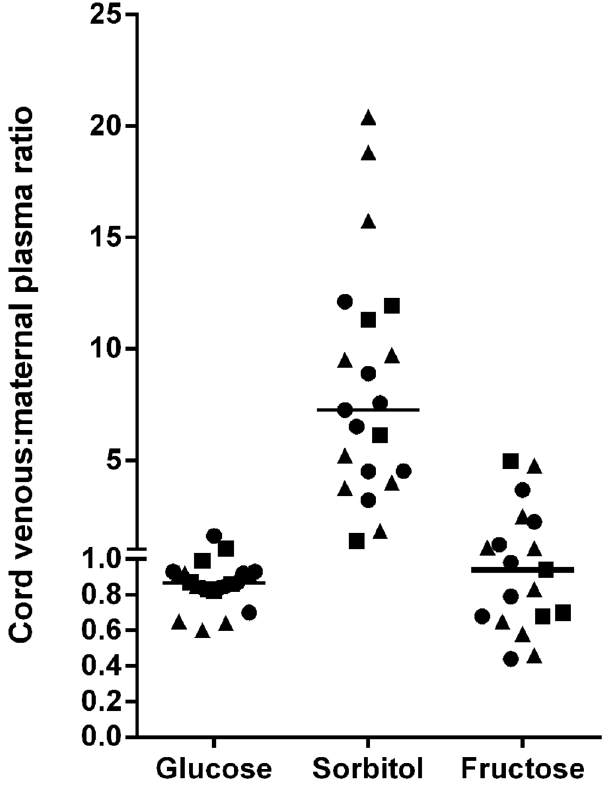
Fig 3. Cord venous blood to maternal plasma ratios of glucose, sorbitol, and fructose. Line represents median ratio. Circle = DM; Square = Lean; Triangle = Overweight/Obese